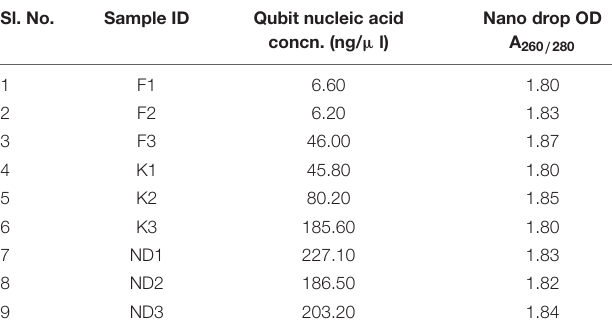
TABLE 1 | Average concentration of metagenomic DNA isolated from different river sediment samples. Sl.